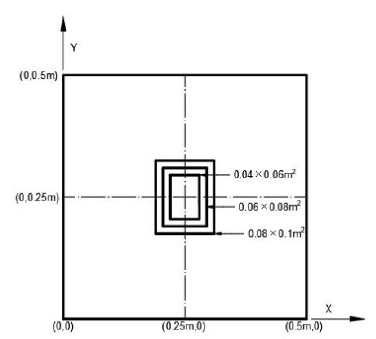
Figure 3. Three di ff erent sizes of PZT actuators surface bonded on the center of the composite Figure 3. Three different sizes of PZT actuators surface bonded on the center of the composite laminate laminate plate.